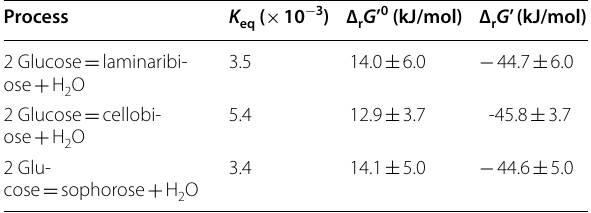
Abbreviations HIFEA: Hydropathy Index For Enzyme Activity; I ah : The average hydropathy index of key amino acid residues in catalytic site; TLC: Thin-layer chromatogra- phy; GHs: Glycoside hydrolases.